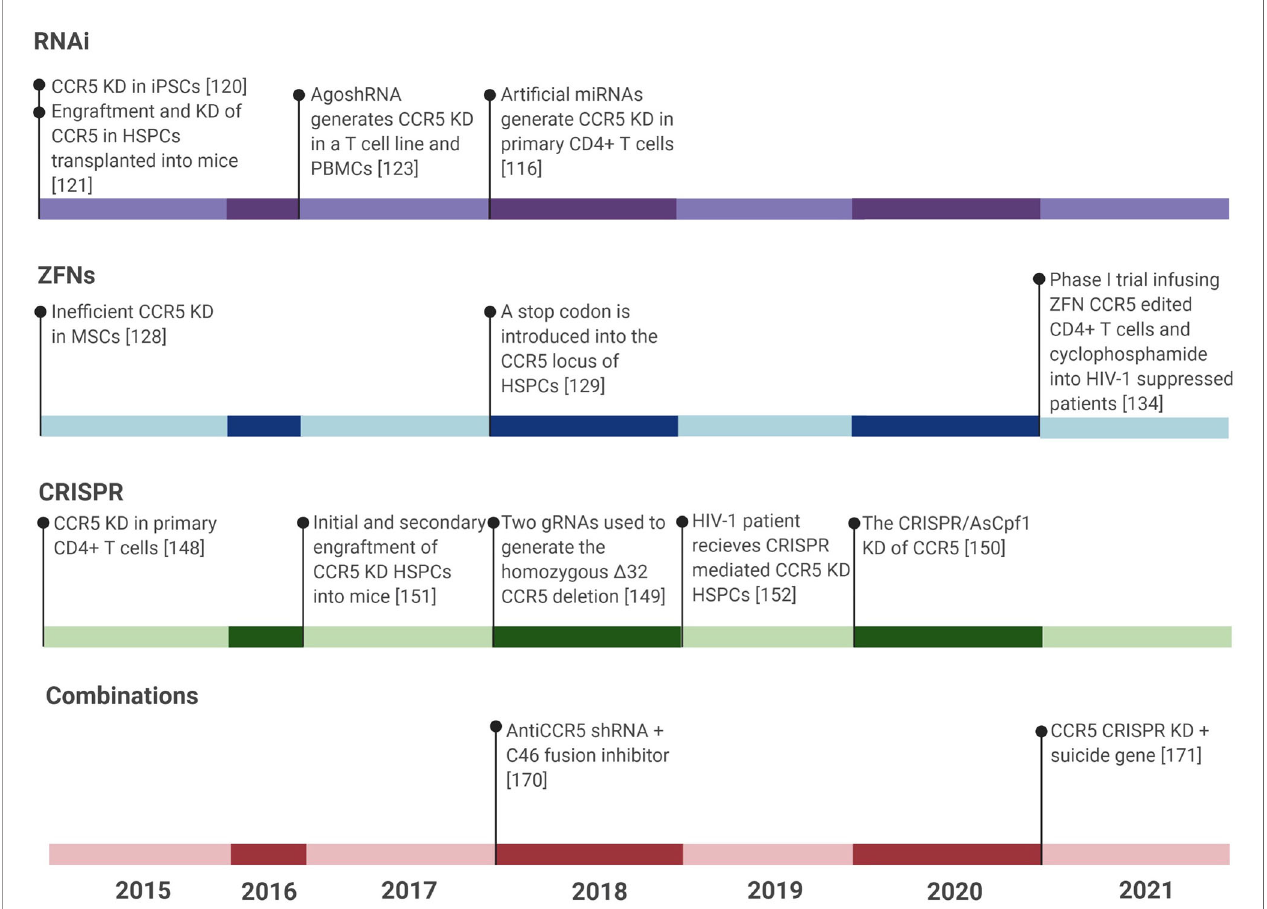
FIGURE 3 | Timeline showing all CCR5 gene editing studies for treatment of HIV-1 infection in the last six years. Gene editing studies include RNAi tools, ZFNs, CRISPR, and combinations of treatments against HIV-1. TALENs were not included due to the publication of only 2 major studies on CCR5 editing using TALENs within the last six years. The last six years have seen the most published research in these areas and so any research prior to this has been left out of this fi gure. KD,